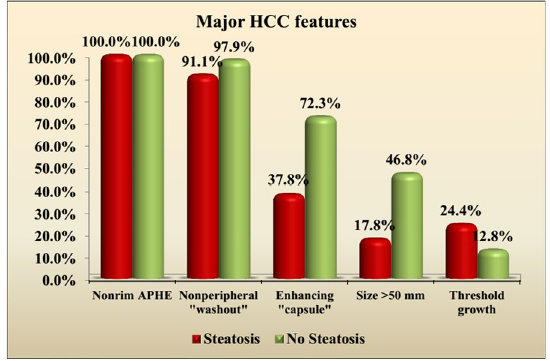
Fig. 1 A graph showing the difference between positive and negative hepatic steatosis patients according to the presence of major HCC